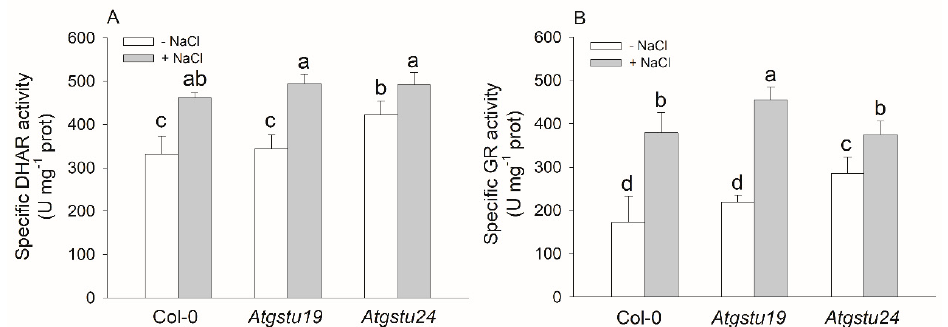
Figure 5. Redox-related antioxidant enzyme activities of two-week-old wild-type (Col-0) and GSTU mutant ( Atgstu19 and Atgstu24 ) Arabidopsis plants treated with 150 mM NaCl for 48 h. ( A ) Dehydroascorbate reductase (DHAR) activity of seedlings. ( B ) Glutathione reductase (GR) activity of plants. Means ± SD denoted by different letters indicate a significant difference between the treatments at a p < 0.05 level according to Duncan’s test.